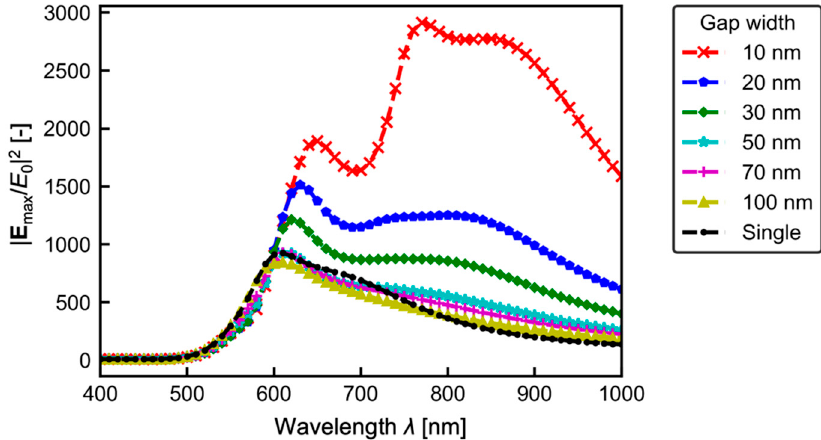
Figure 6. Maximum electric field enhancement in the numerical domain.